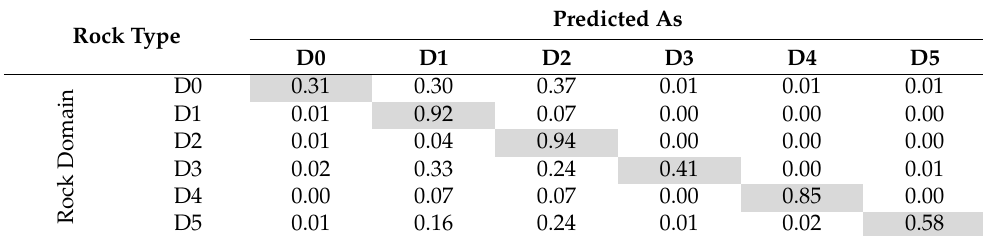
Table 12. Confusion matrix for 3D RF modeling for NW. Table 13. Confusion matrix for 3D RF modeling for CEN.